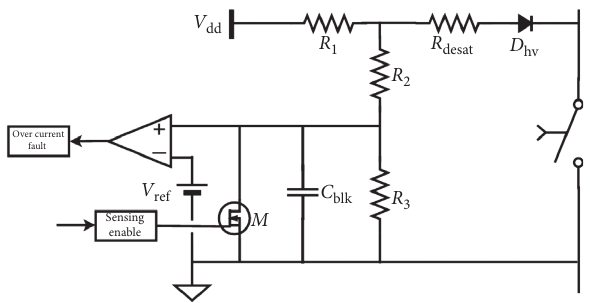
Figure 11: A desaturation circuit using voltage divider.